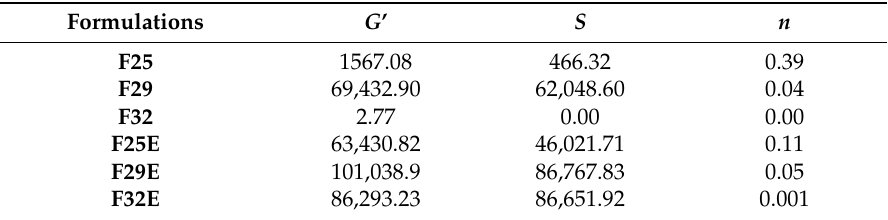
Storage modulus ( G ’), formulation strength ( S ), and viscoelastic exponent ( n ) of all